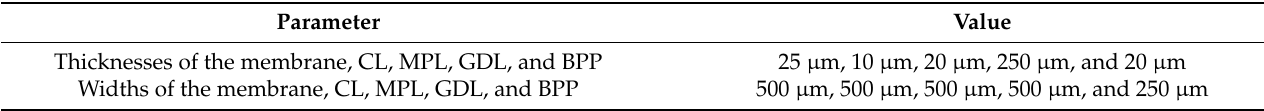
Table 4. Geometry parameters of the present model.